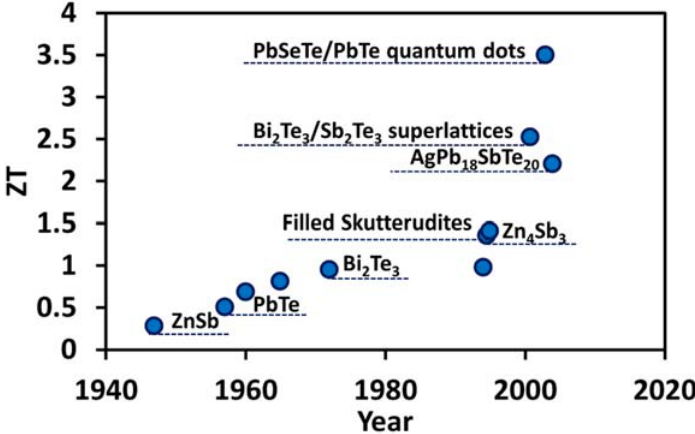
Figure 6. Key historical developments in figure of merit (ZT) of thermoelectric materials over the last century. ZT value for commercial TE materials are less than unity. Nanostructured ultra-thin film TE materials have shown ZT up to 3.5. Figure drawn using information in references